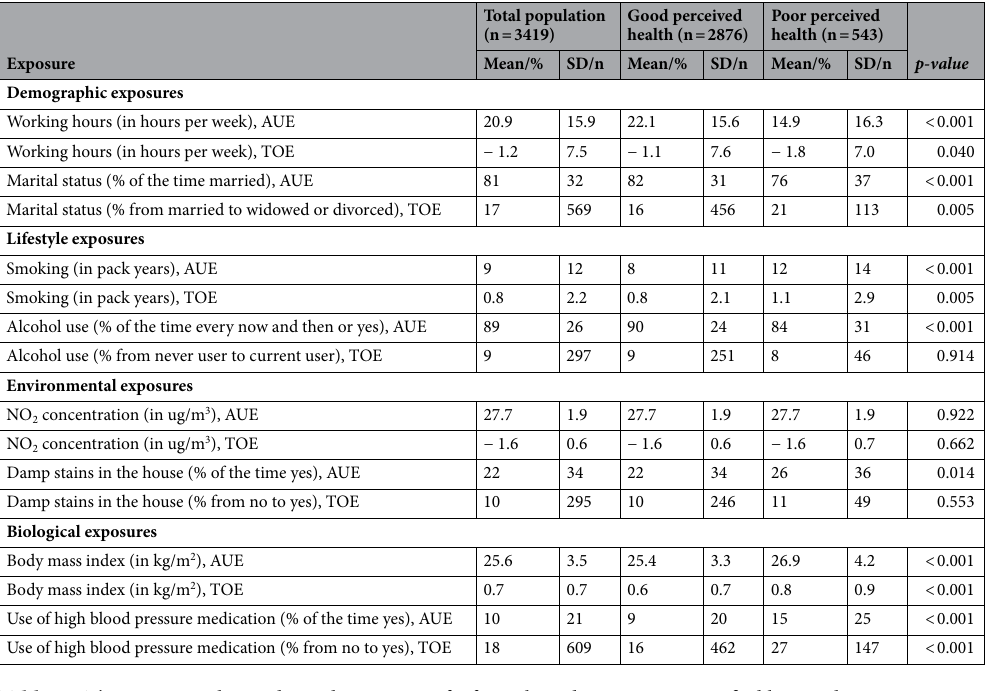
Table 2. The average value and trend over time of a few selected exposures, stratified by good or poor perceived health status at round 6. The AUE and TOE indicate the average value of the exposure over time and the average trend in the exposure over time for continuous exposures, respectively. For the categorical exposures, the proportion of the time that participants were in a particular category (AUE) and the proportion of participants for whom a change from one reference category to another category occurred during the rounds (TOE) is presented. AUE Area-Under-the-Exposure, TOE trend-of-the-exposure. P -values were tested using the independent samples t test and chi-square test.